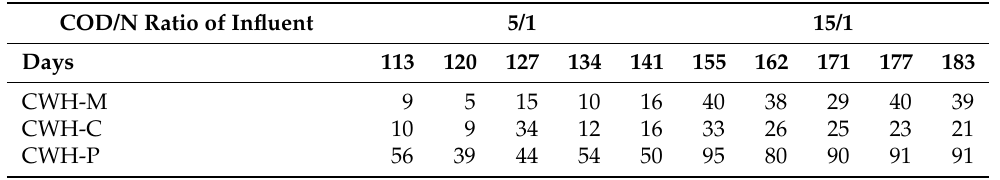
Table A3. Estimated denitrification (%) in the unplanted CWH over the experimental period.